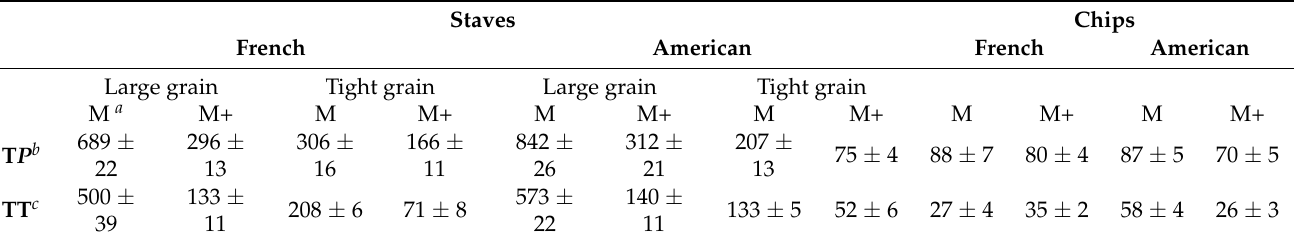
Table 1. Phenolic indices of the different oak extracts